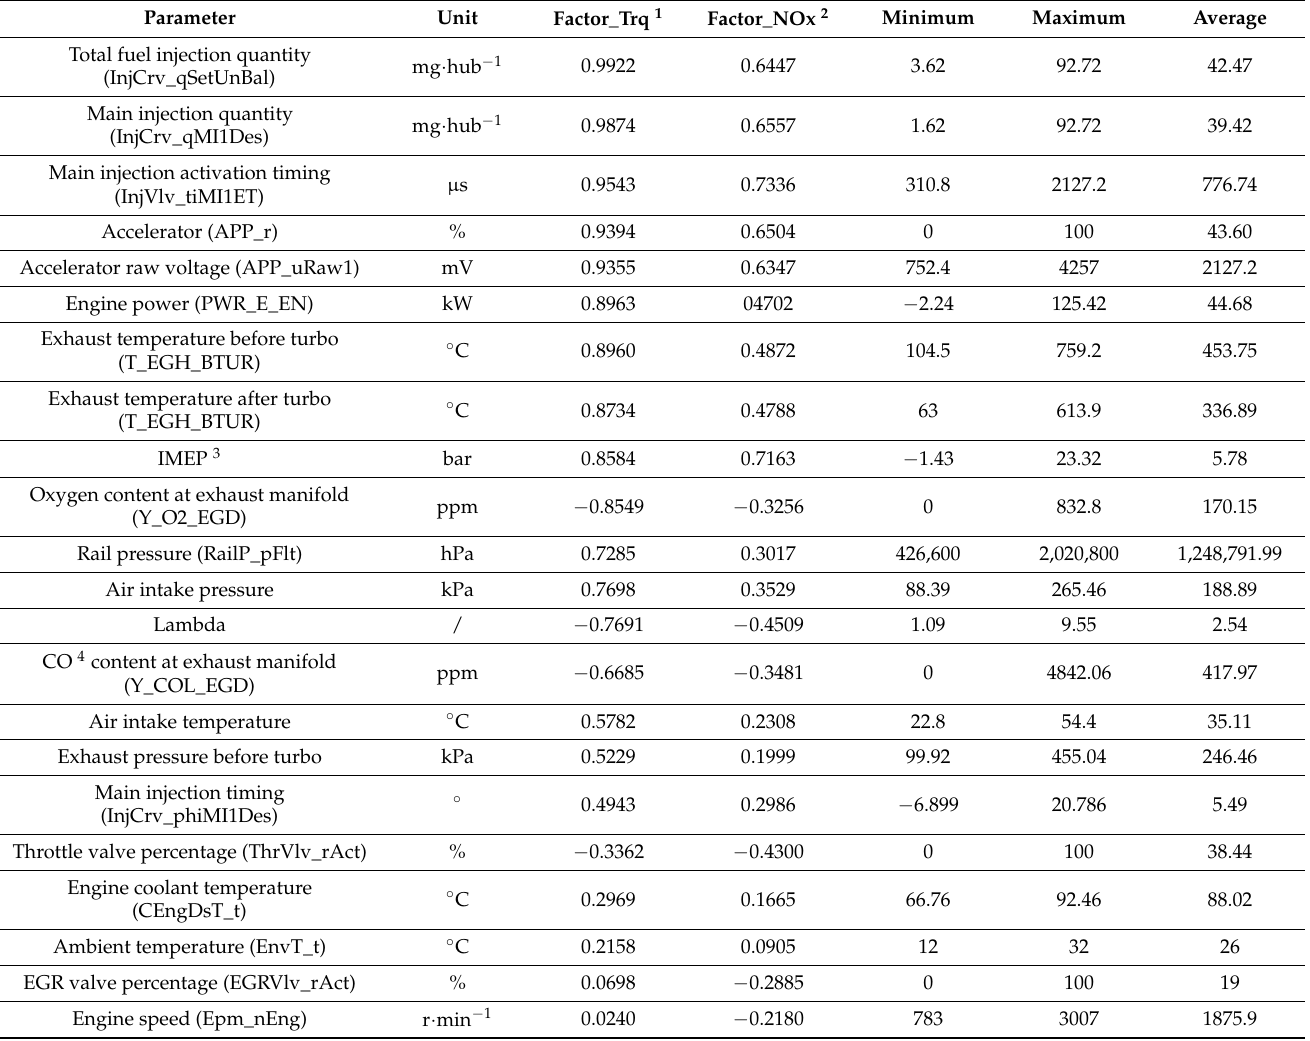
Table 2. Engine torque and NOx raw emission main influencing factors.